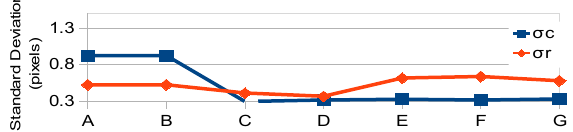
Figure 8. Average values for the standard deviations of discrepancies in tie points coordinates of 5 rectified image pairs with different sets of IOP and ROP.